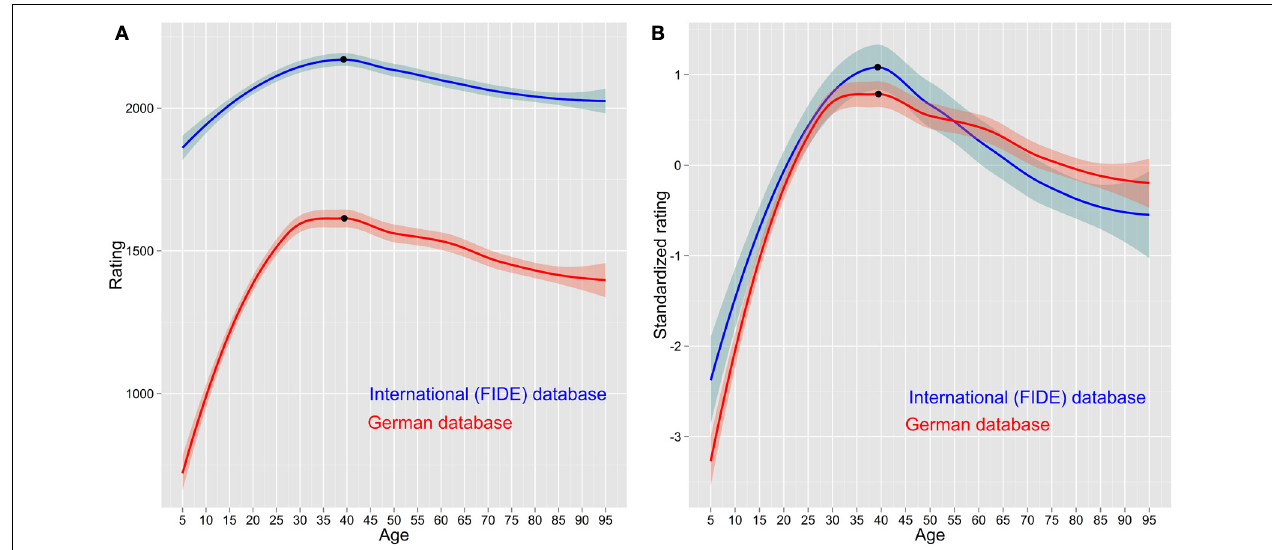
FIGURE 2 | (A) Average skill trajectories, in Elo with 95% confidence intervals, over the years in FIDE database (blue color) and German (red) database. (B) Average standardized skill trajectories, in Z -values with 95% confidence intervals, over the years in FIDE database (blue color) and German (red) database.